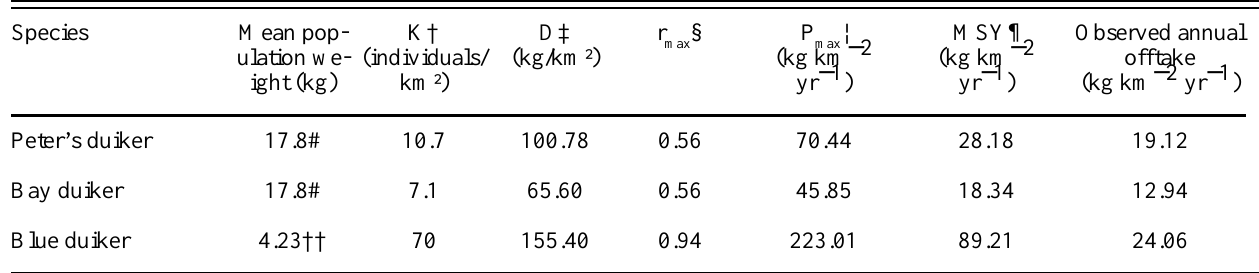
Table 1. Population and harvest characteristics for three species of duiker.